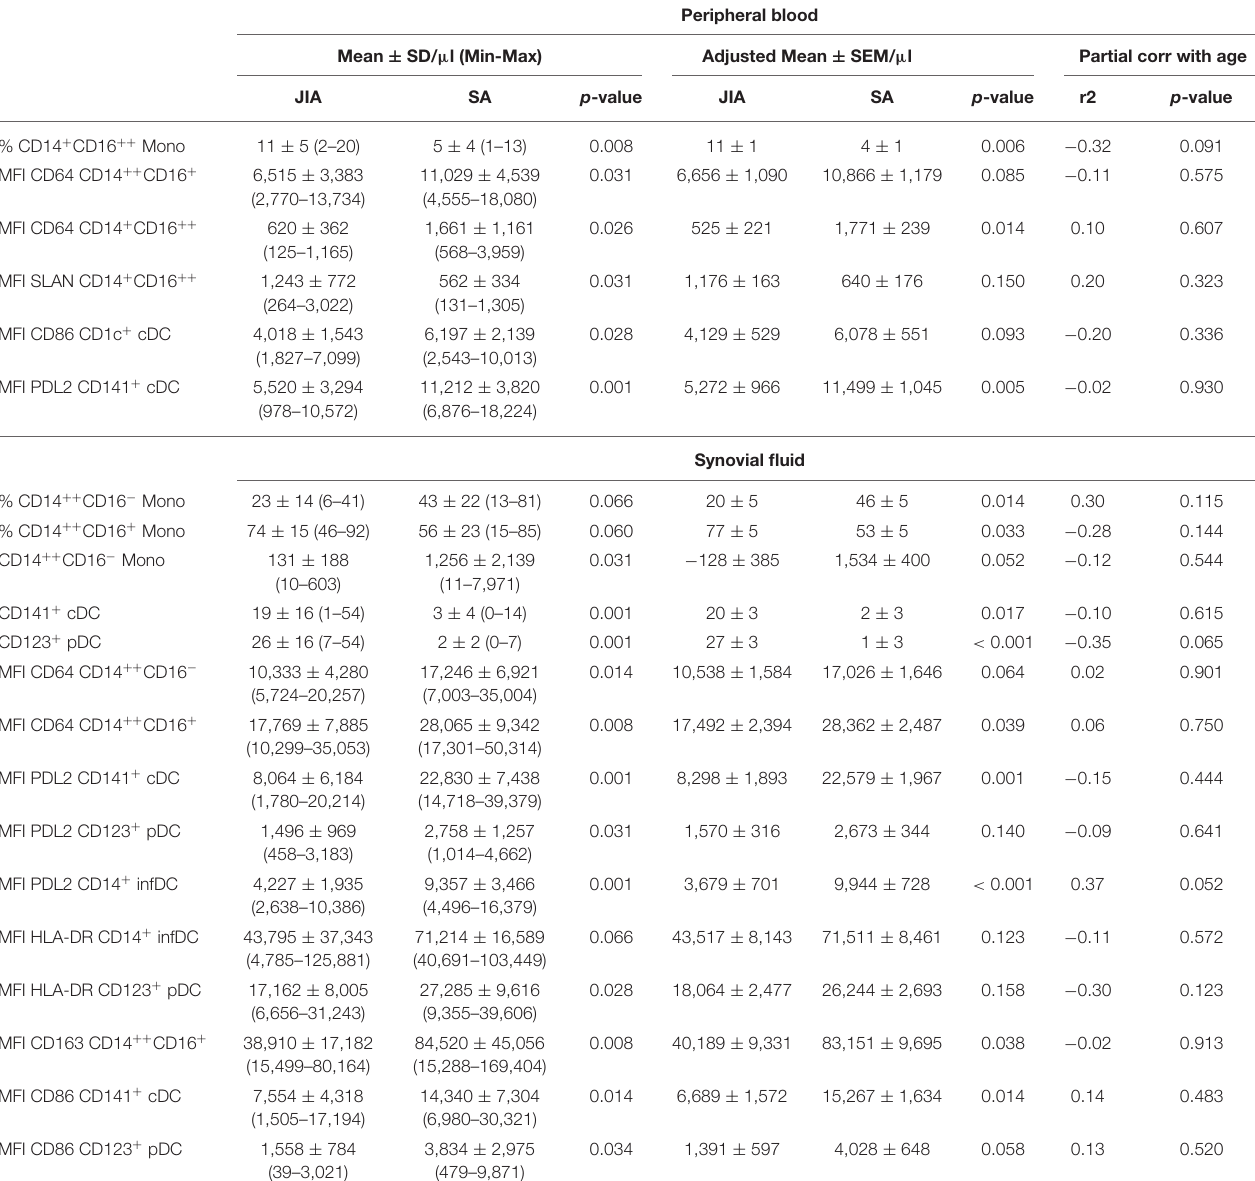
TABLE 3 | Proportion, cell counts and mean fluorescence intensities of activation markers on monocytes and DC subsets that discriminate between JIA and SA. Peripheral blood Mean ± SD/ µ l (Min-Max) Adjusted Mean ± SEM/ µ l Partial corr with age